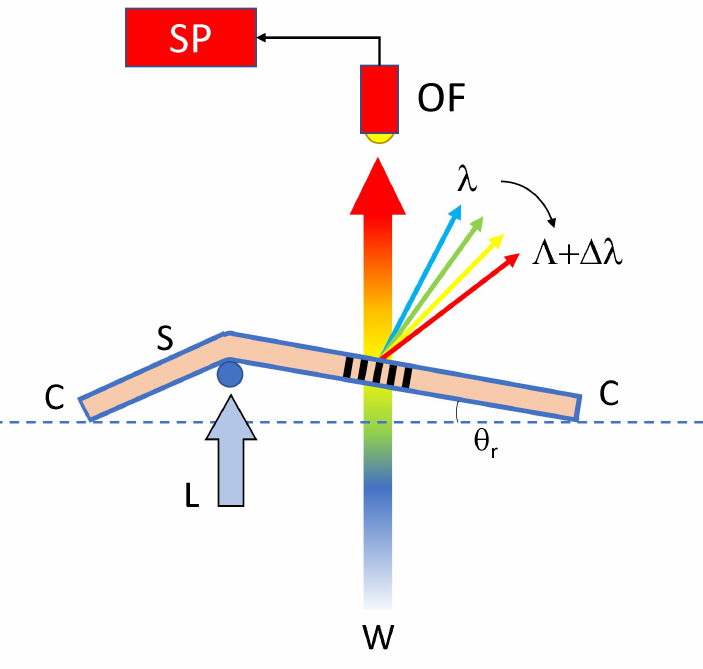
Figure 8. Setup used to read the wavelength changes as a function of the rotation angle θ r . By increasing the applied displacement L, the angle increases and the transmission grating selects different wavelengths ranging from light blue to deep red. C = clamping; S = Sample; OF = Optical Fiber; W = White light source; SP =